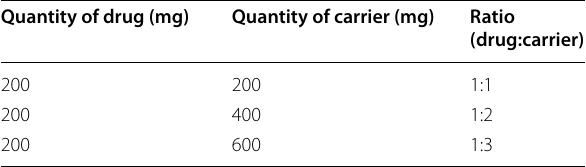
Table 1 Ratio for physical mixture and solid